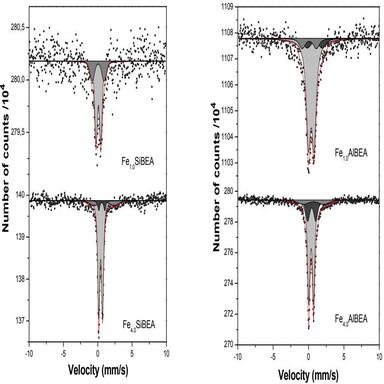
The room temperature 57Fe Mossbauer ¨ spectra of a) FexSiBEA zeolites and b) FexHAlBEA zeolites.